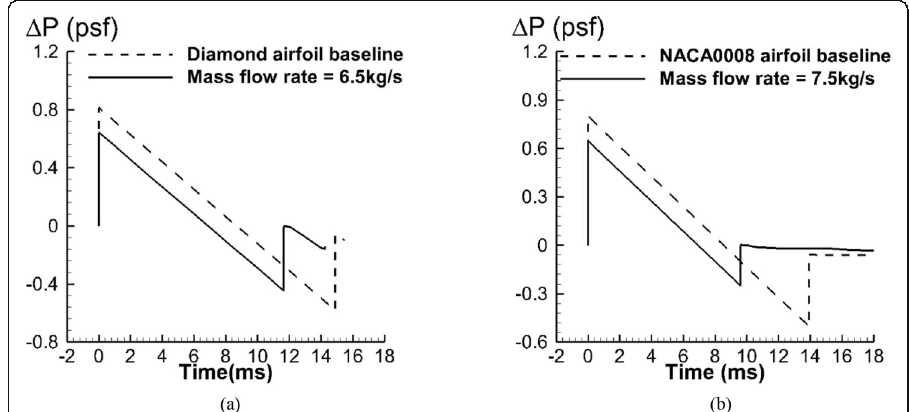
Fig. 21 The comparison of ground boom signatures a for the diamond airfoil baseline and the optimized diamond airfoil at the mass flow rate = 6.5 kg/s b for the NACA0008 airfoil baseline and the optimized NACA0008 airfoil at the mass flow rate = 7.5